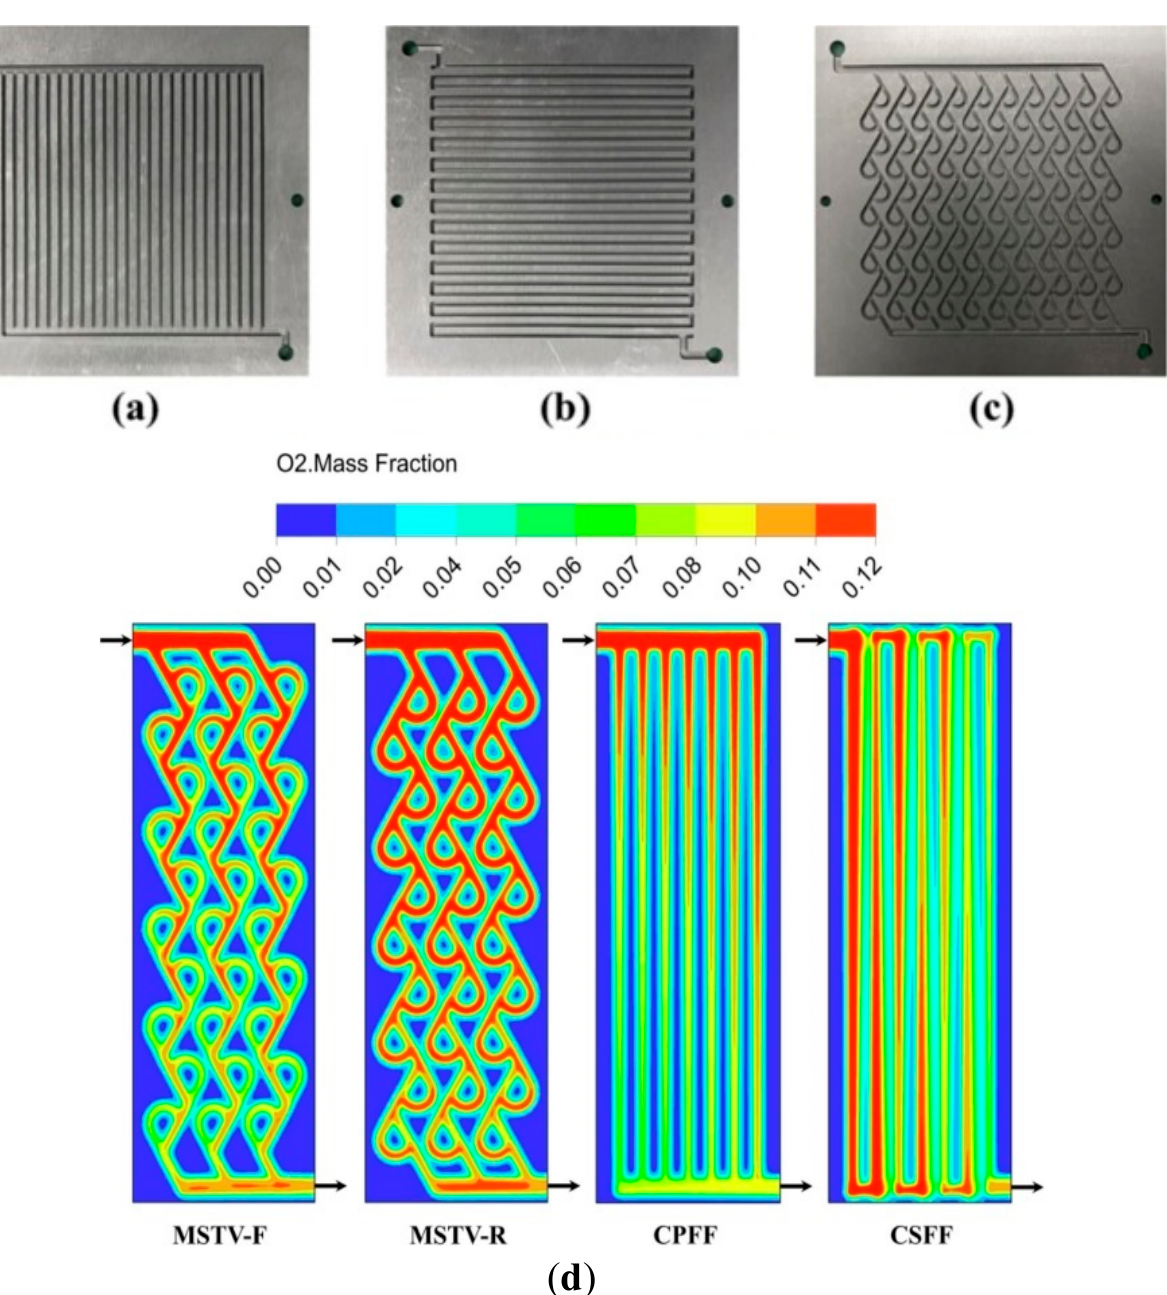
Figure 8. The multistage TV microchannels in the proton’s cathode exchange membrane fuel cell (PEMFC). ( a – c ) Fabricated MSTV CPFF and CSFF structures. ( d ) Simulated results show a higher fraction of oxygen both in forward and reverse flow (marked as MSTV-R and MSTV-F) compared to the conventional parallel flow field (CPFF) and conventional serpentine flow field (CSFF). Reprinted with permission from [70] copyright © 2023 Elsevier.